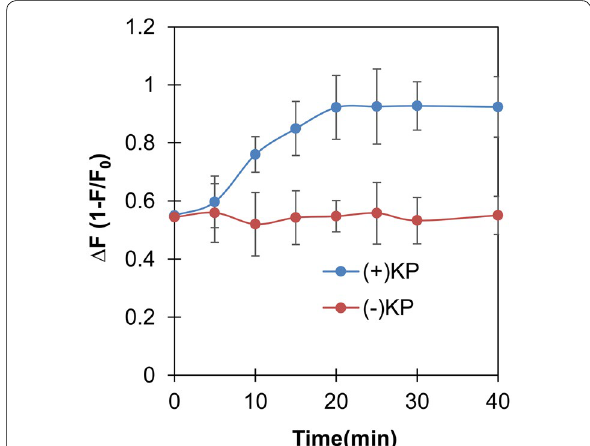
Fig. 2 Time-dependent decrease of fluorescence in the mixture of GO and UVB-irradiated DNA at 618 nm compared to intact DNA. GO was mixed with ssDNA that had been irradiated with UVB light for various time. F and F 0 is fluorescent of the mixture and intact DNA without GO respectively